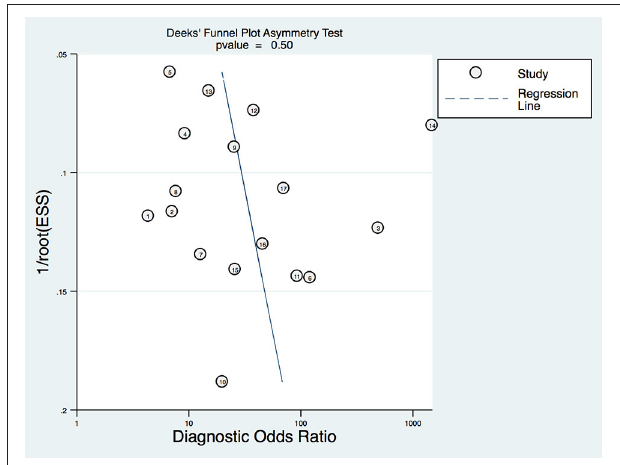
FIGURE 8 | Deek’s funnel plot for the assessment of publication